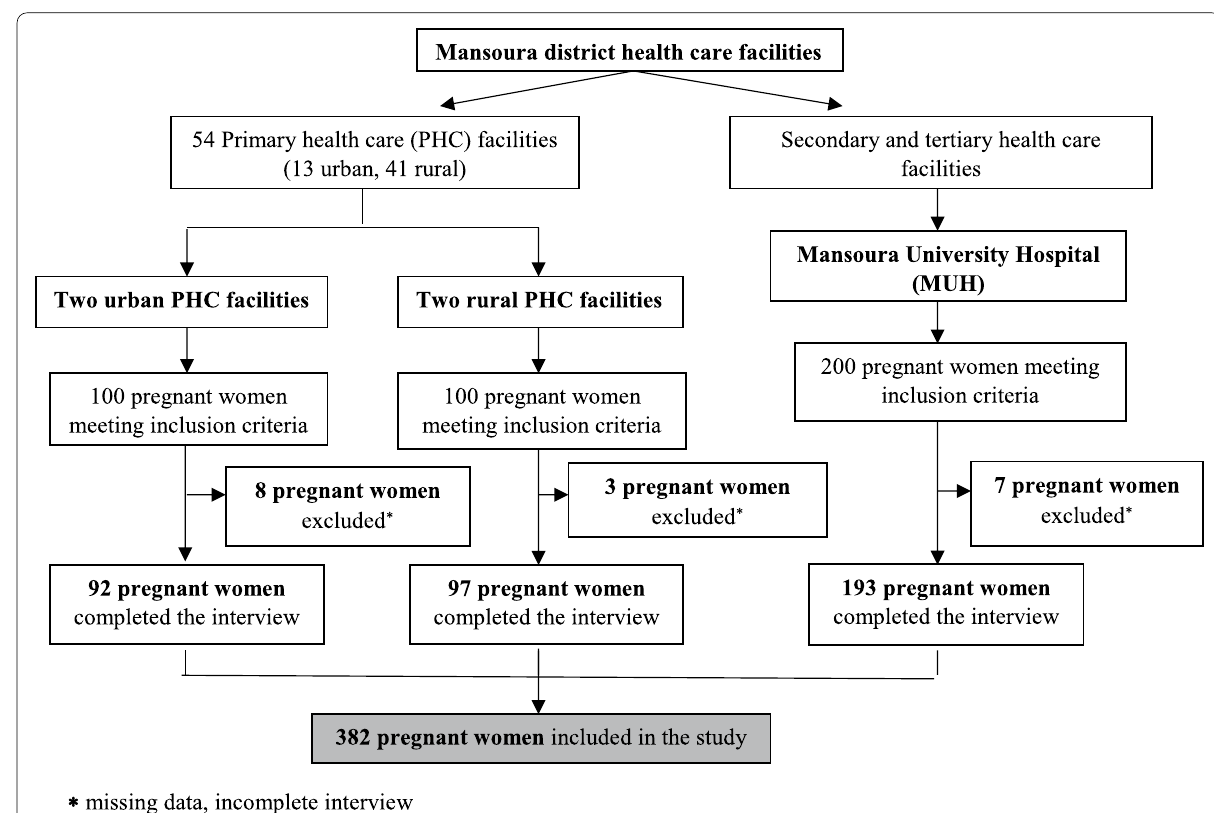
Fig. 1 Flow chart of participants’ sample. *Missing data, incomplete